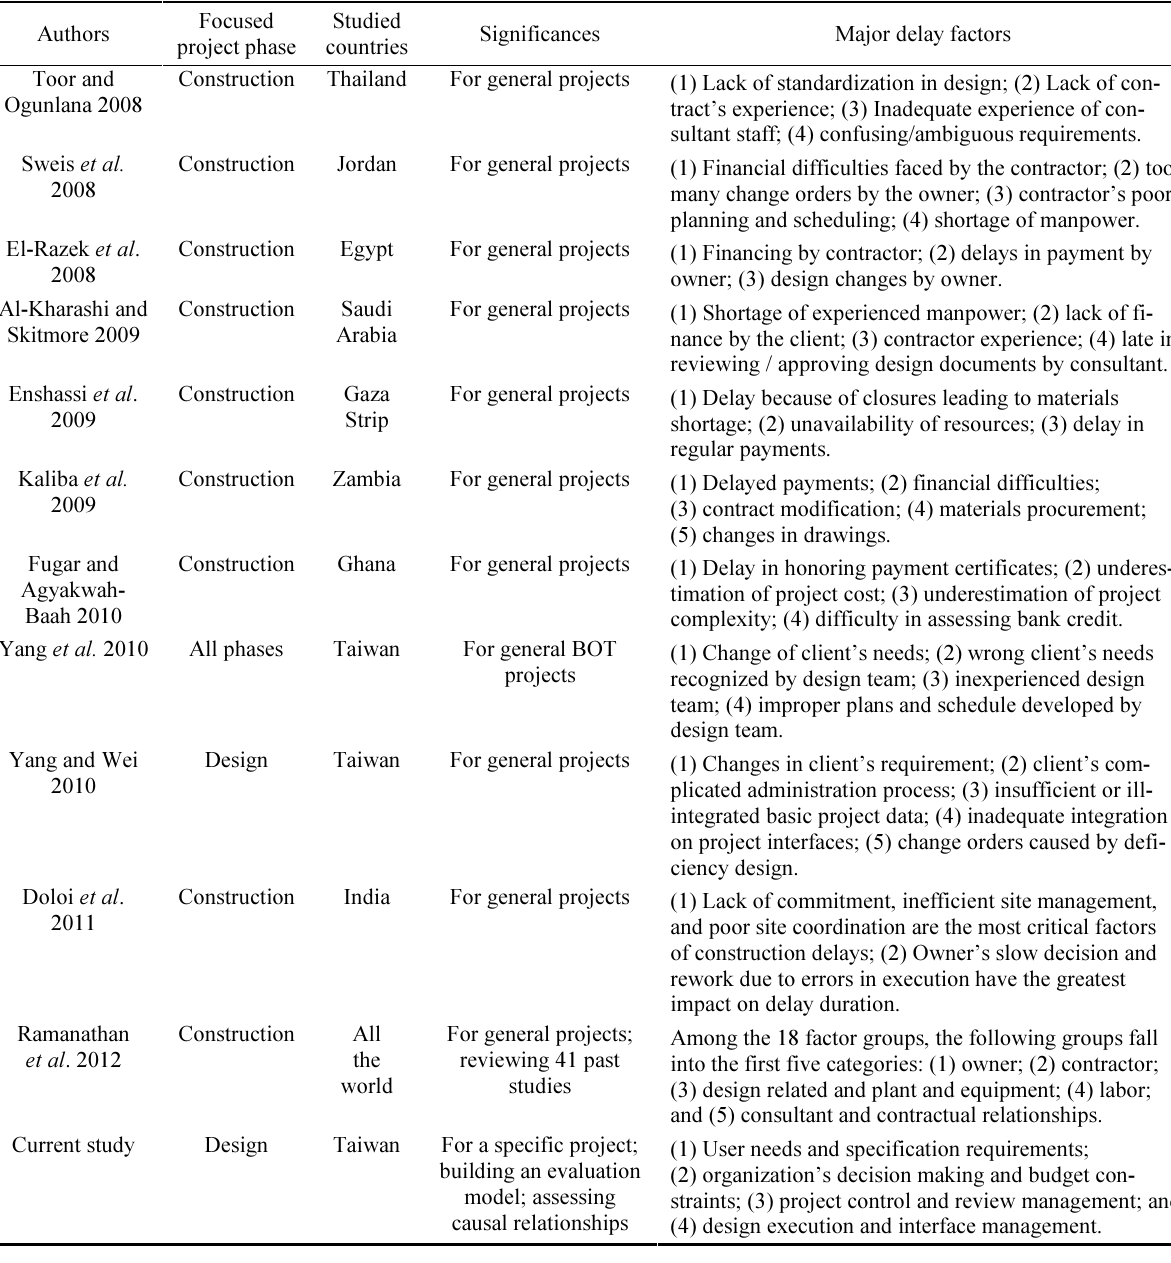
Table 1. Comparisons of recent studies in identifying delay factors for construction projects